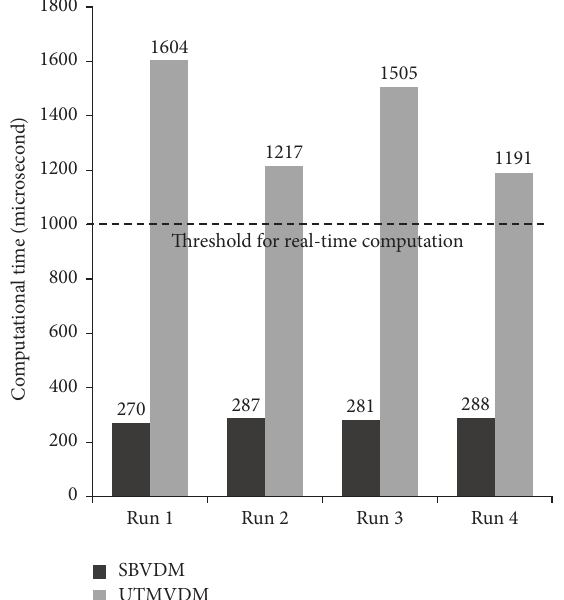
Figure 21: The computational time for responses in SBVDM and conventional